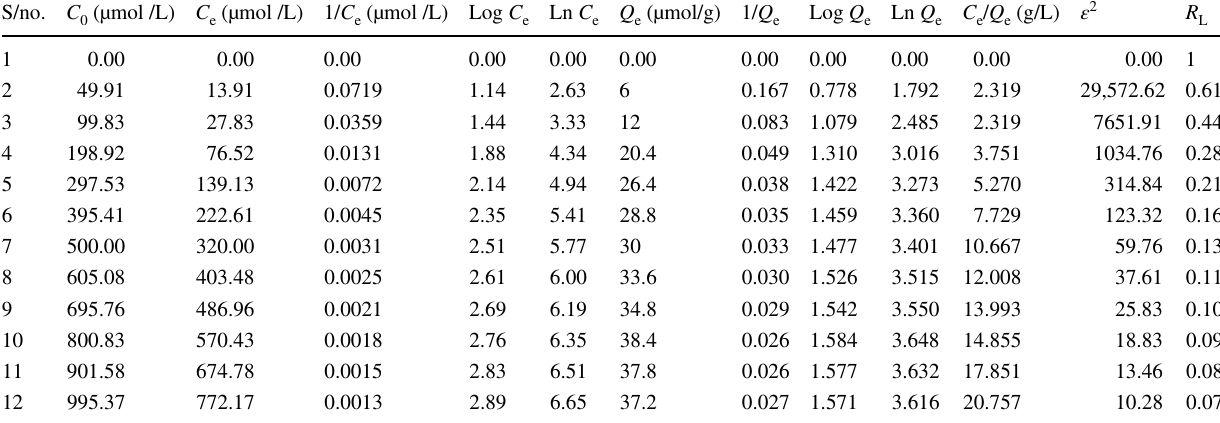
Table 2 Parameters for plotting Langmuir, Freundlich, Temkin and Dubinin–Radushkevich adsorption isotherms of paraquat onto Ayous saw- dust